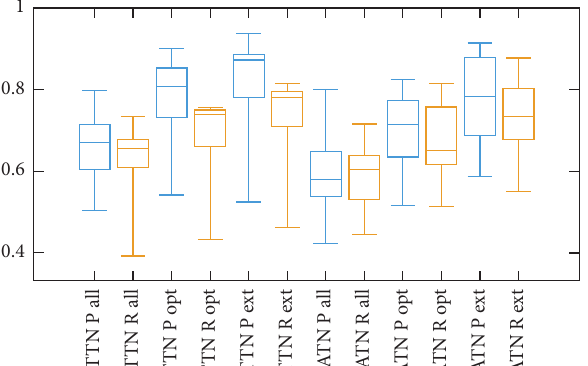
N TT Figure 18: Boxplots of precision P and recall R values ( y -axis) induced by the measures of Table 5 and underlying the F -scores of Table 6 (first six columns) and Table 7 (last six columns). Distri- butions are distinguished by considering all features (all) or subsets of them generated by the genetic optimization opt or ext .